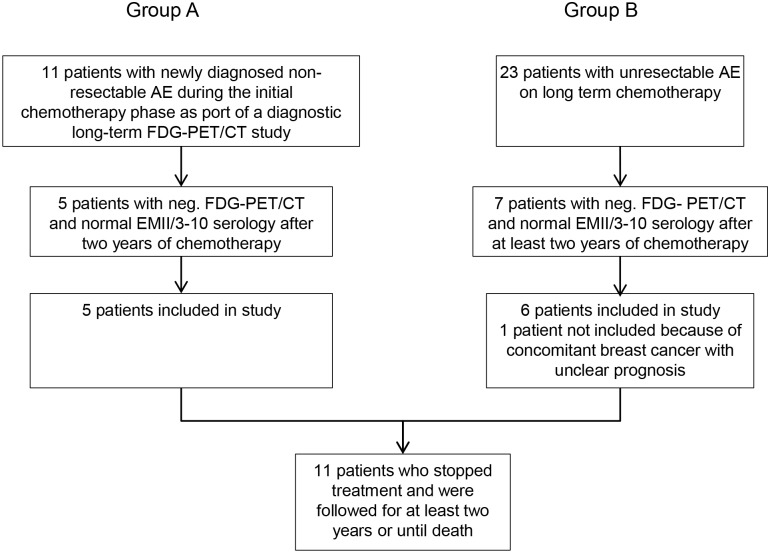
Disposition of the study population.